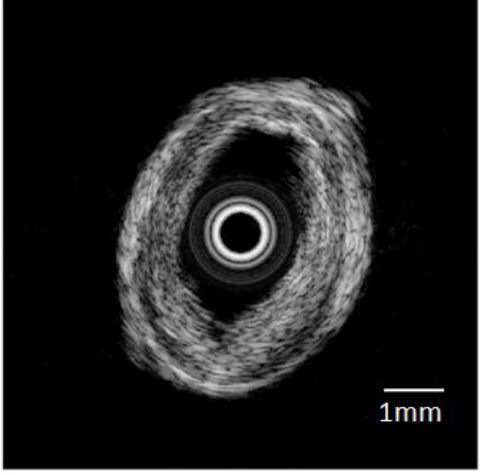
Figure 8. Ultrasonic image of human coronary artery captured by the IVUS transducer